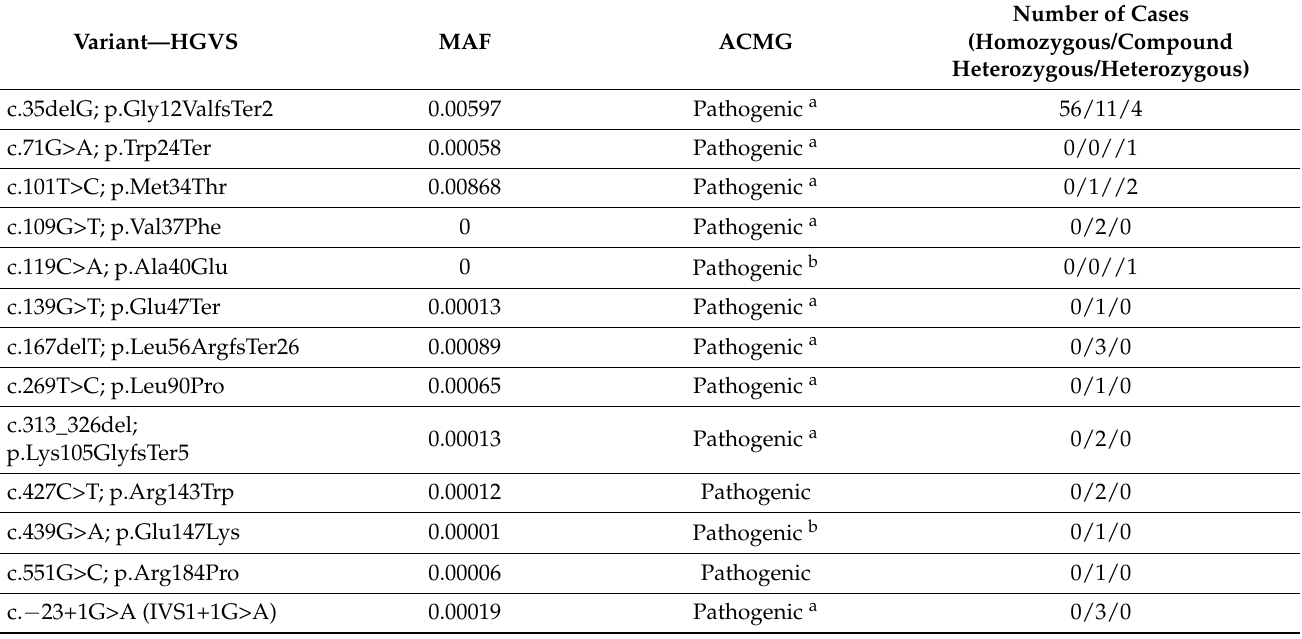
Figure 3. Distribution of inheritance patterns ( A ), GJB2 ( B ), and non- GJB2 variants ( C ) in the Hungarian NSHL patient cohort. Diagnosed patients: N = 92. Numbers within a section of a circular graph indicate the number of patients (percentage of patients). AR: autosomal recessive; AD: autosomal dominant; XR: X-linked recessive. Table 1. Pathogenic GJB2 variants identified in the Hungarian NSHL patient cohort. Variant—HGVS